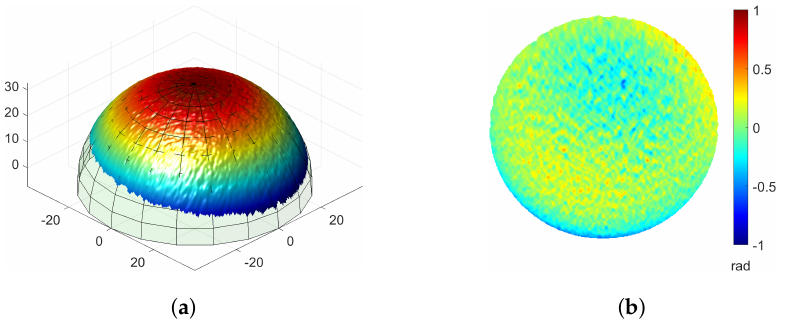
Figure 10. Accuracy evaluation of the measuring result of a sphere. ( a ) Overlap 3D measured data of the sphere shown in Figure 9c with an ideal sphere. ( b ) Error map of ( a ) (RMS: 0.13mm, Mean: − 0.23 × 10 − 3 mm, σ : 0.13mm).